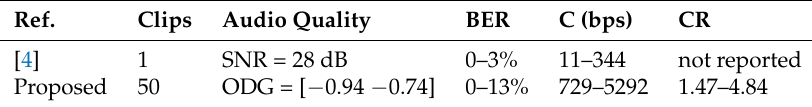
Table 9. Performance